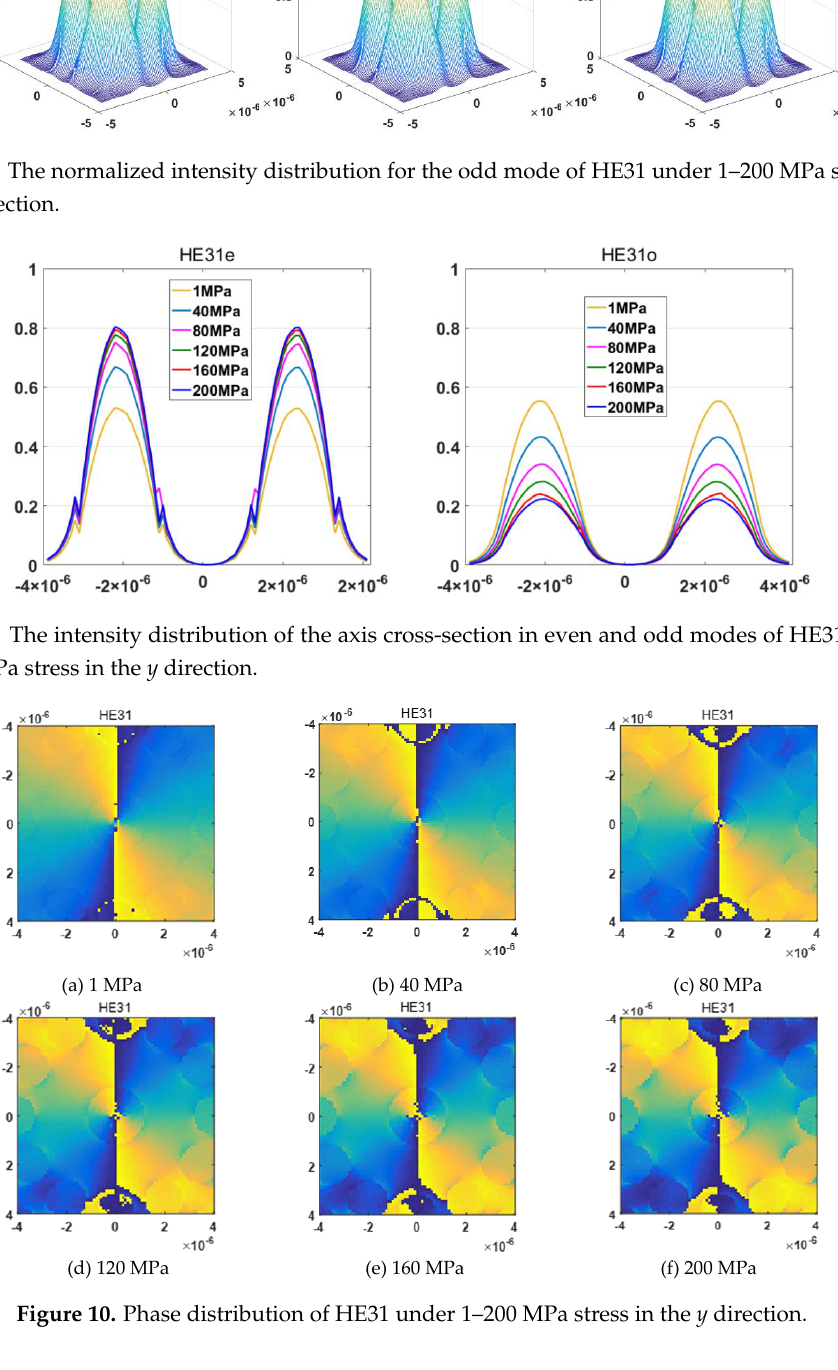
Figure 10 . Phase distribution of HE31 under 1–200 MPa stress in the y direction. Figure 10. Phase distribution of HE31 under 1–200 MPa stress in the y